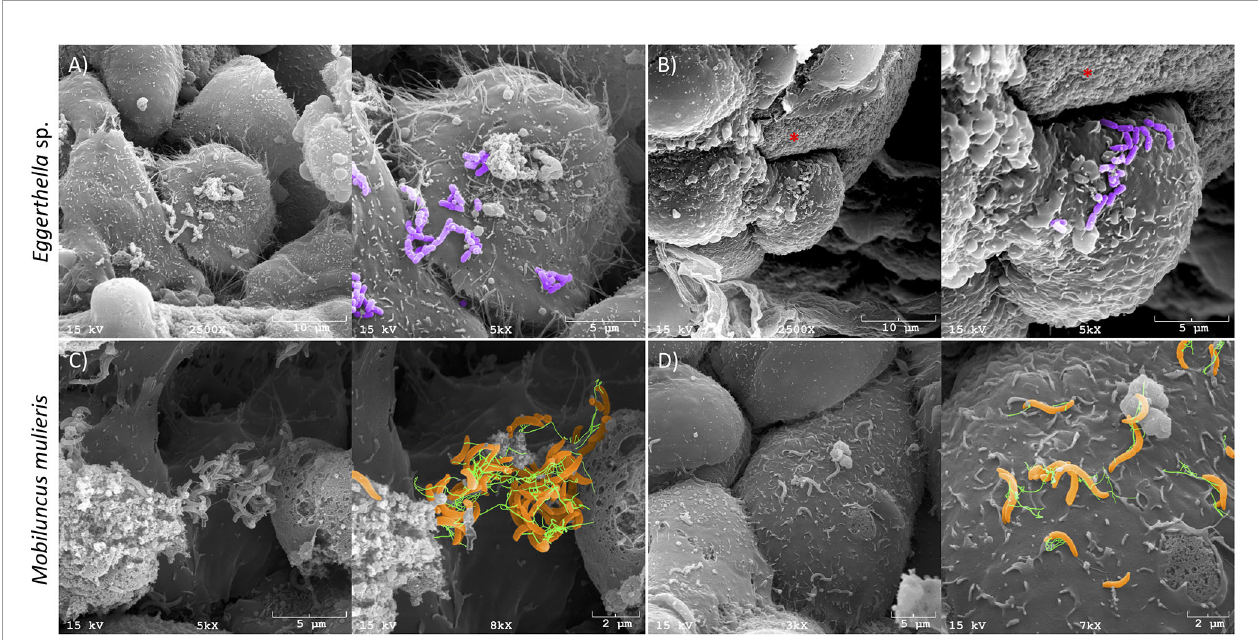
FIGURE 1 | Eggerthella sp. and M. mulieris colonize 3-D human cervical epithelial cellmodels. Pseudo-colored scanning electronmicroscopy (SEM) images of (A) and (B) , Eggerthella sp. MVA1 and (C,D) , M. mulieris UPII-28Ishowingcolonization of 3-D cervical epithelial cells. Eggerthella sp. MVA1 exhibit a coccobacillimorphology and colonized 3-D cervical cells insmallclusters or short chains. M. mulieris UPII-28I cellsexhibita curved rod-shaped morphologyand werepseudo-colored orange with fl agella-likestructures pseudo-colored green.The * indicates thecollagen-coatedmicrocarrier beadsusedto generate the3-D cervical epithelial